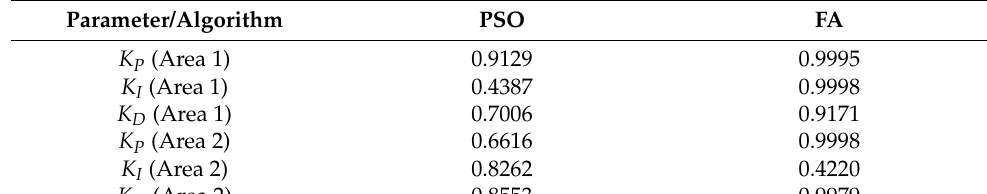
Table 4. The PSO-PID and FA-PID controller parameters.